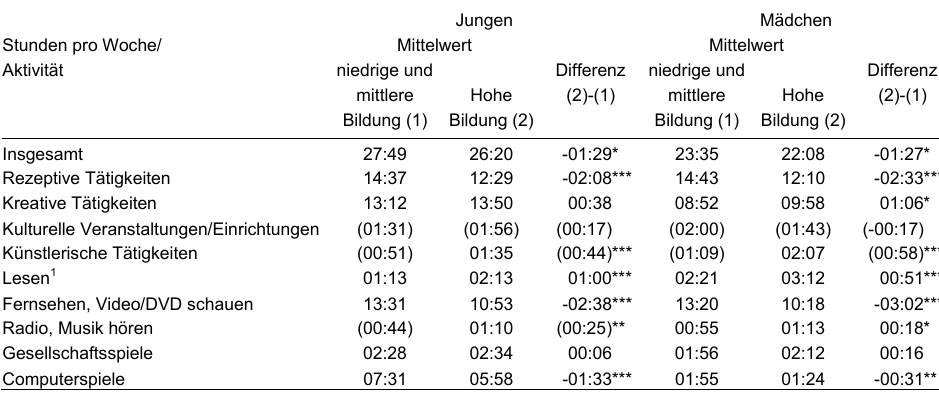
Tabelle 7 : Zeitverwendung für kulturelle und musisch-ästhetische Aktivitäten